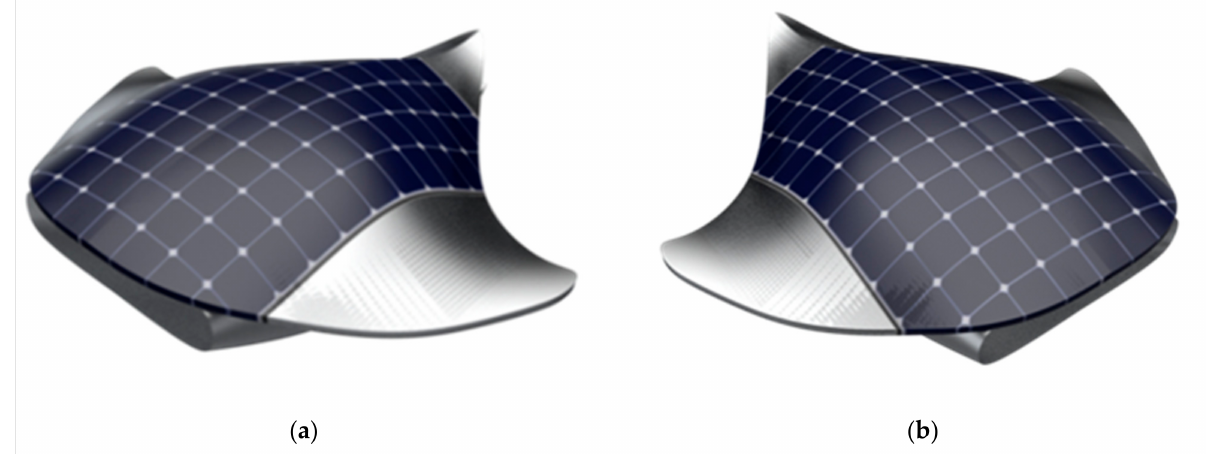
Figure 16. Digital prototype of the marine drone: ( a ) left side; ( b ) right side.